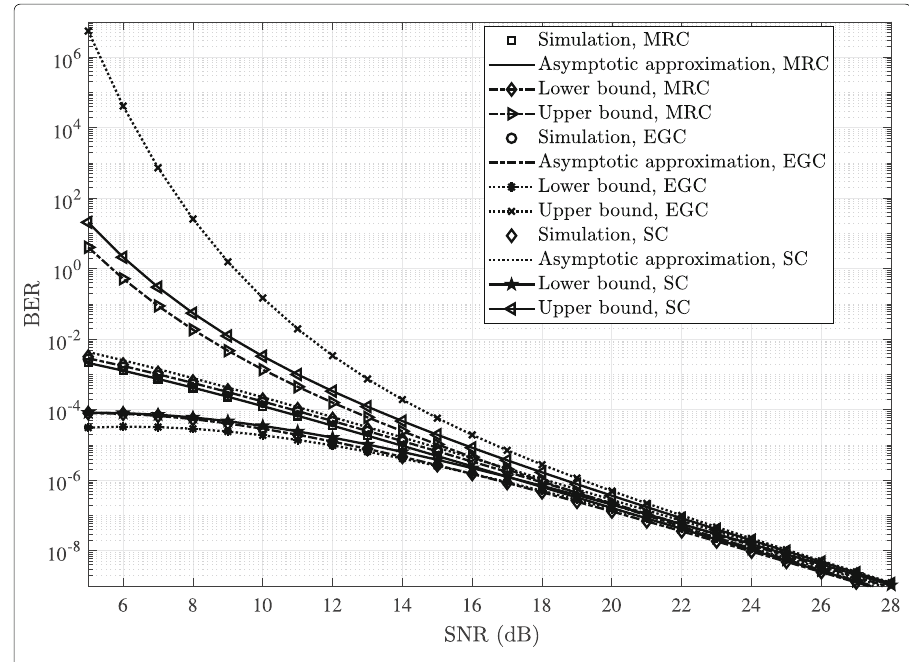
Fig. 5 BER curves for the asymptotic approximation, lower bound, and upper bound for MRC, SC, and EGC, over correlated BX fading channels. The number of branches is N = 2, the fading parameter is m = 1.5, and (cid:12) C 1 , 0 2 × 2 , 0 2 × 2 ; 0 2 × 2 , C 2 , 0 2 × 2 ; 0 2 × 2 , 0 2 × 2 , C 3 the correlation structure is C b = (cid:24) (cid:23) √ √ C 1 = C 2 = C 3 = 0.4; 0.4,1 1,